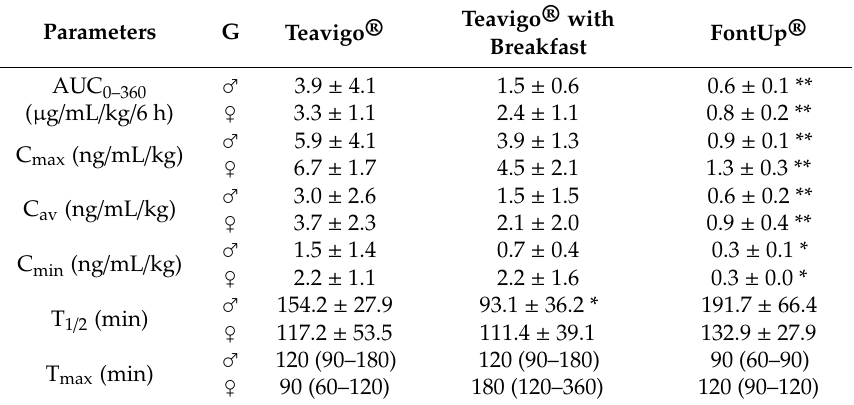
Figure 1. Consort flow chart and schematic representation of the study design and the blood sampling: The experimental design includes the study groups, the timeline of blood extractions after the intake of epigallocatechin-3-gallate (EGCG), and the methodology to analyze the samples. UPLC-ESI-MS/MS = ultra-performance liquid chromatography-electrospray tandem mass Table 3. Plasma kinetic parameters for EGCG after the three preparations. spectrometry. Table 2. Anthropometric data of the participants included in the study.